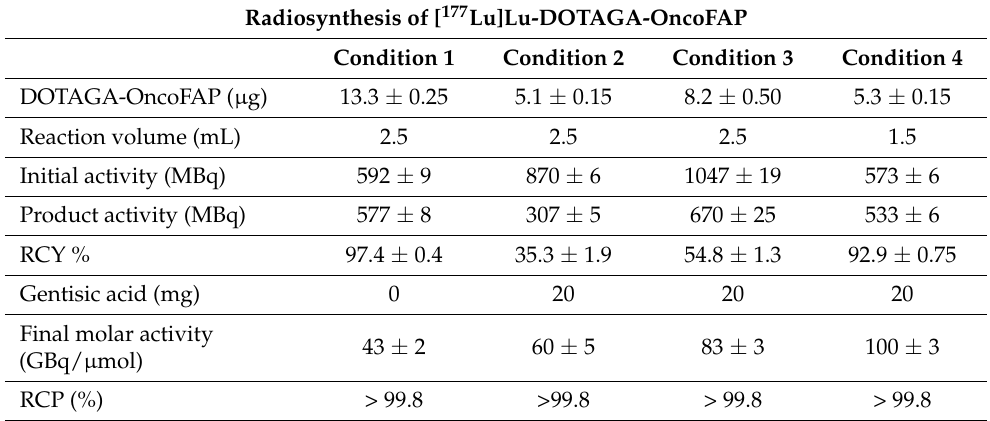
Table 10. Different conditions used for the synthesis of [ 177 Lu]Lu-DOTAGA-OncoFAP.